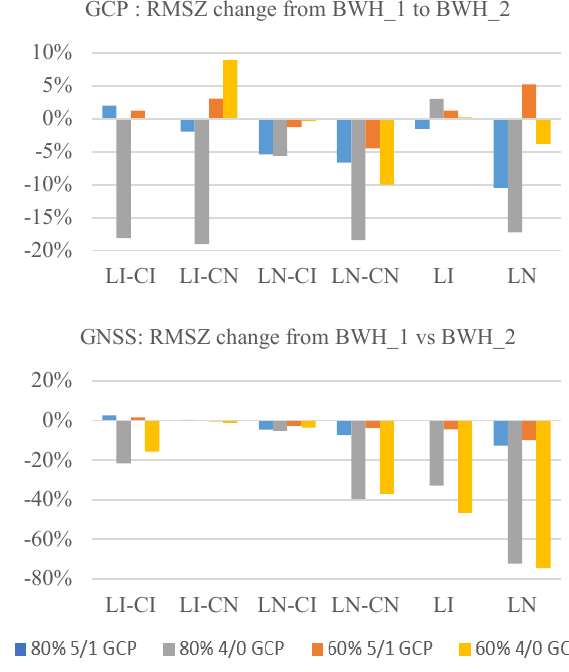
Figure 8 . BWH_1 vs BWH_2 RMSZ change for each of the six configurations and side-lap percentage. Top: GCP case; bottom: GNSS case. Positive values correspond to BWH_1 being less accurate, negative ones to the